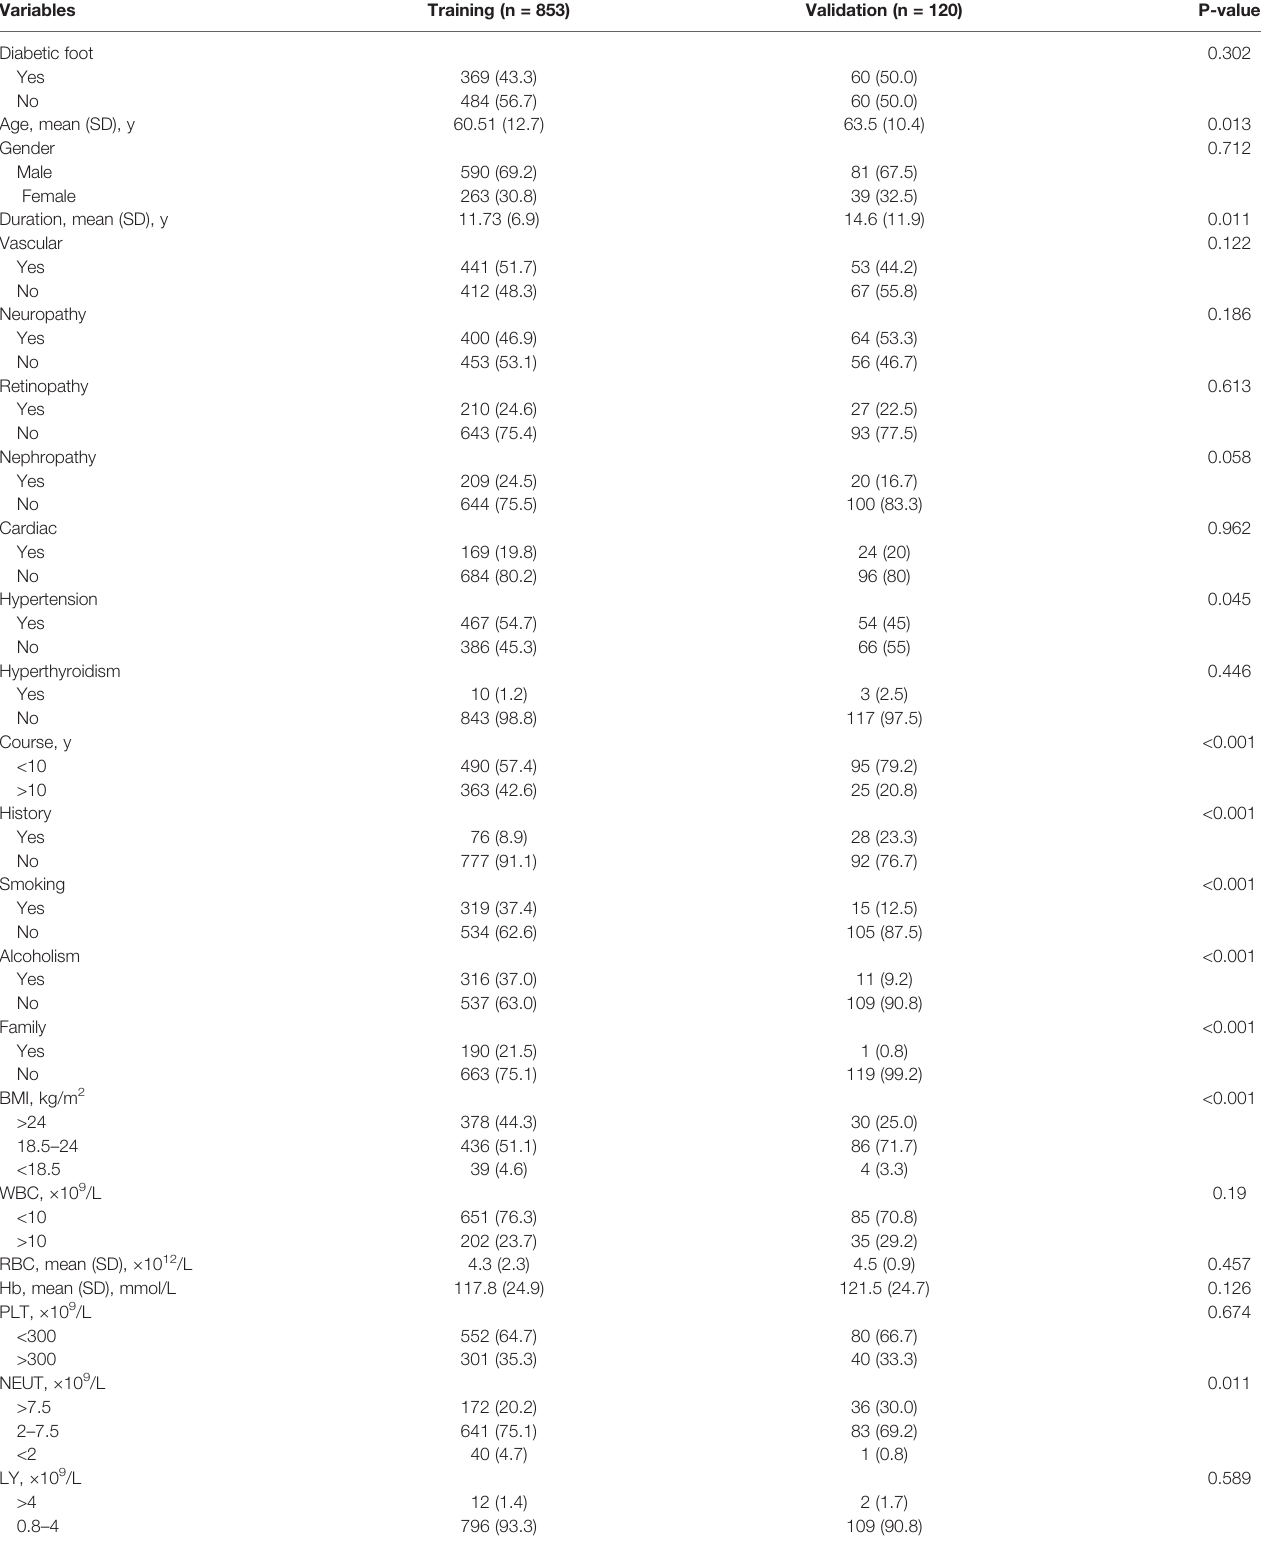
TABLE 1 | Participant